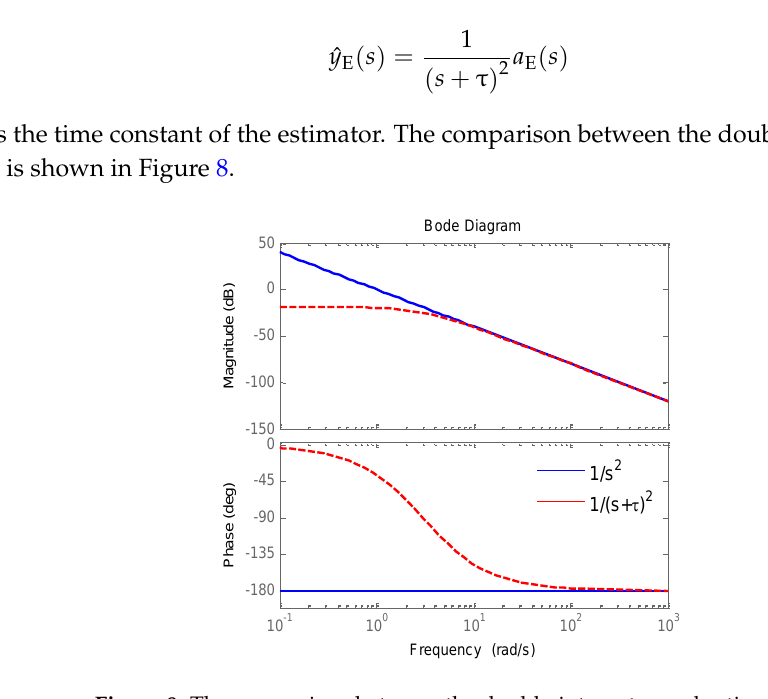
1 s Figure 9. The block diagram of maglev vehicle-bridge system with estimator.